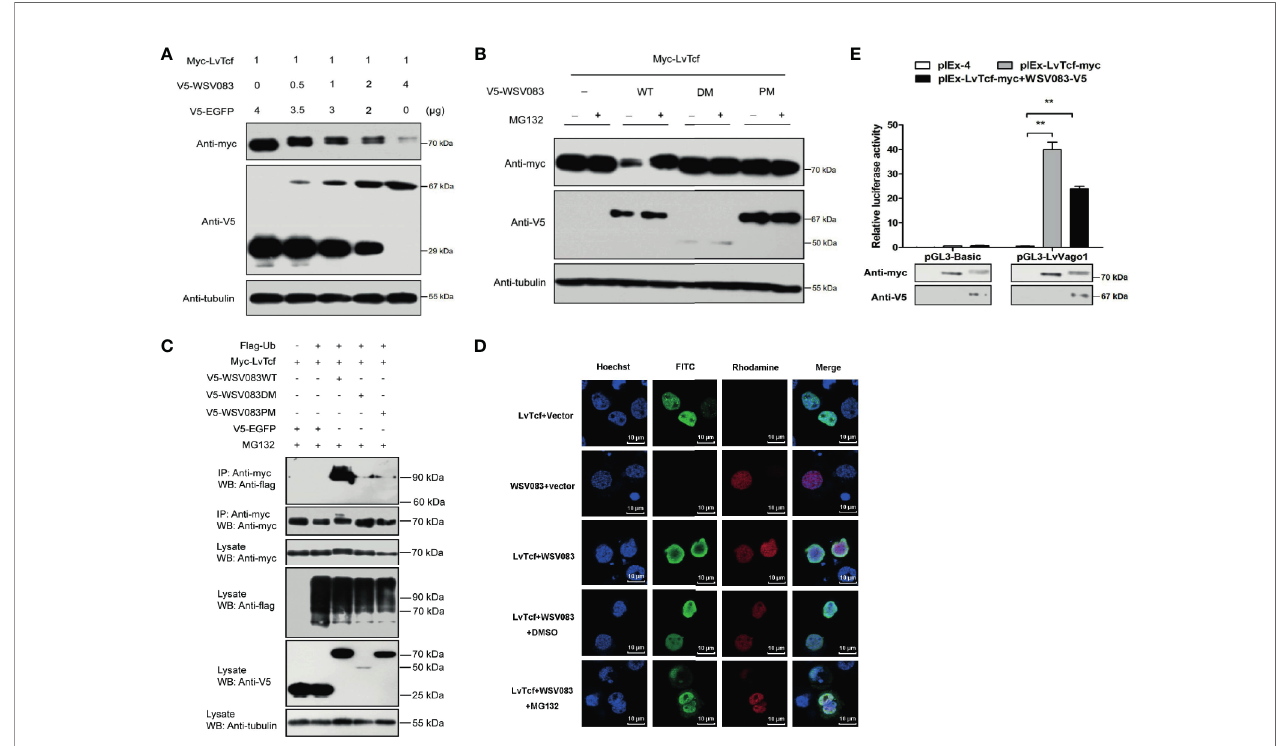
FIGURE 5 | WSV083 promotes the degradation of LvTcf via the ubiquitin-proteasome pathway. (A) High Five cells were transfected with Myc-LvTcf and increasing doses of V5-WSV083 expression plasmid (0, 0.5, 1, 2, and 4 m g), as indicated. After 48 h, the cells were lysed and analyzed by western blotting. (B) High Five cells were co-transfected with Myc-LvTcf, pIEx-4, V5-WSV083WT, or its mutants. After 24 h, the cells were treated with or without 10 m M MG132 as indicated. Anti-Myc, anti-V5, and anti-tubulin antibodies were used for western blotting. (C) WSV083 promoted the polyubiquitination of LvTcf. High Five cells were co-transfected with Myc-LvTcf, FLAG-Ub, and V5-WSV083, as indicated. After 24 h, the cells were treated with 10 m M MG132 for 12 h. Whole-cell extracts were immunoprecipitated with anti-Myc and protein A beads followed by western blotting with anti-FLAG. (D) WSV083-phosphorylated LvTcf was transferred into the cytoplasm for degradation. Cells were transfected with Myc-LvTcf, V5-WSV083, or both. After 24 h, cells co-transfected with Myc-LvTcf and V5-WSV083 were treated with MG132 or DMSO for 18 h. Immuno fl uorescence experiments were performed with a primary mouse anti-Myc, rabbit anti-V5 as well as secondary FITC anti-mouse and rhodamine anti-rabbit antibodies. Finally, the cells were observed under a confocal laser-scanning microscope. Scale bar = 10 m m. (E) Dual-luciferase reporter assays indicated that WSV083 inhibited the effect of LvTcf on the LvVago1 promoter. Data were analyzed via the student ’ s t -test (**p <